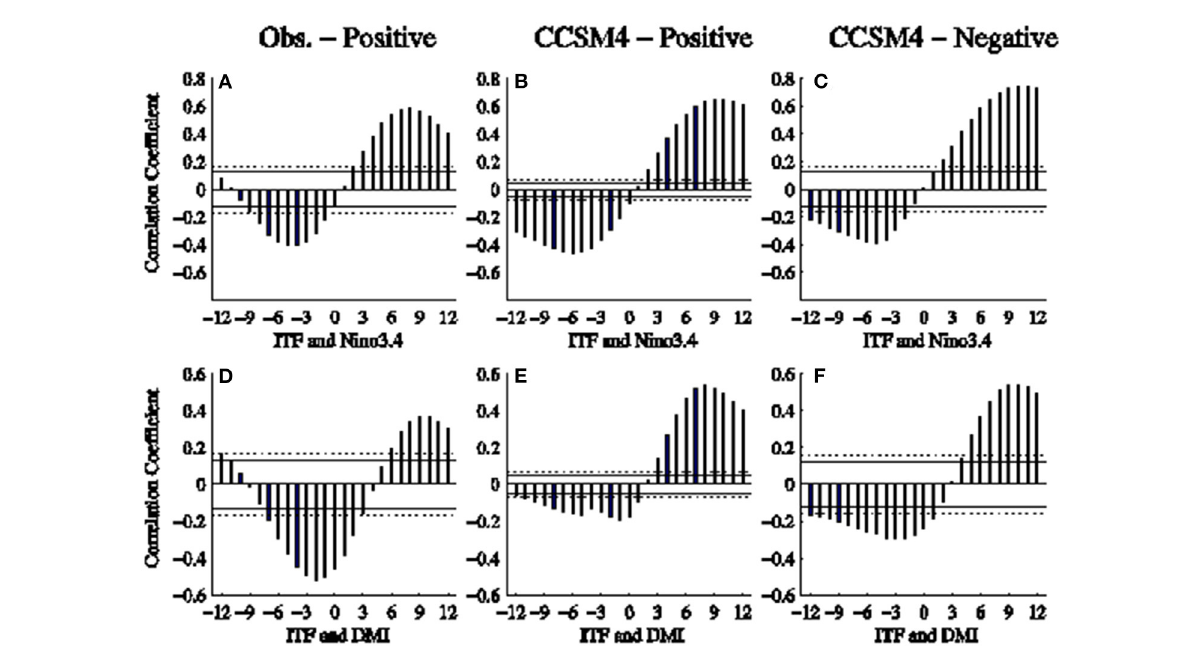
FIGURE7 Lag correlations between the ITF transport anomalies and the Niño3.4 indices (A–C) or DMI (D–F) in the observations and in CCSM4 simulations. The observed (simulated) ITF transport is the geostrophic transport above the main ocean thermocline across the IX1 section between western Australia and Java in reference to the 700m level-of-no-motion based on the XBT data (CCSM4 simulations). (A,D) are based on observational data; (B,E) are based on the CCSM4 simulations during the positive phases of the decadal variability; (C,F) are based on the CCSM4 simulations during the negative phases of the decadal variability. Solid and dashed horizontal lines represent the 95% and 99% confidence levels,